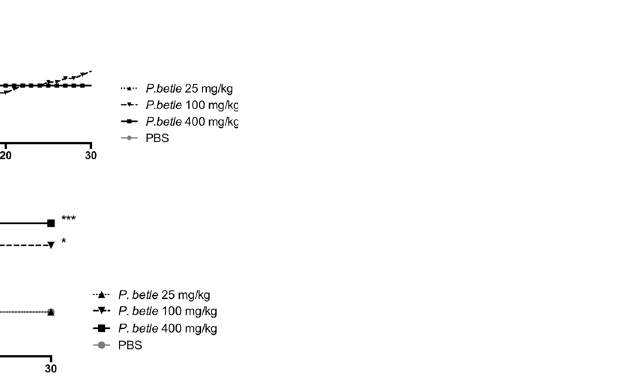
Fig 4. Clinical scores and survival of T . gondii -infected mice treated with P . betle extract. Mice were intraperitoneally administrated with P . betle extracts at 25, 100 and 400 mg/kg/day or PBS from 1 to 7 days post-infection with 10 3 PLK tachyzoites per mouse. Clinical scores (A) and survival (B) were monitored for 30 days post-infection in the mice. The clinical scores represent the mean total values for all mice used in this study. Data represent the mean values of all the mice used in two independent experiments performed together ( P . betle extract at 100 and 400 mg/kg/day, PBS, n = 6 + 6; P . betle extract at 25 mg/kg/day, n = 6). The clinical scores were analyzed by two-way ANOVA plus Tukey – Kramer post-hoc analysis at the time points indicated ( * Difference between PBS and P . betle extract at 400 mg/kg/day, P < 0.05; # Difference between PBS and P . betle extract at 100 mg/kg/day, P < 0.05). Survival curves were generated with the Kaplan – Meier method. According to the log-rank test, the differences between the PBS and P . betle extracts were significant ( * Difference between PBS and P . betle extract at 100 mg/kg/day, P < 0.05; *** Difference between PBS and P . betle extract at 400 mg/kg/day, P < 0.001).